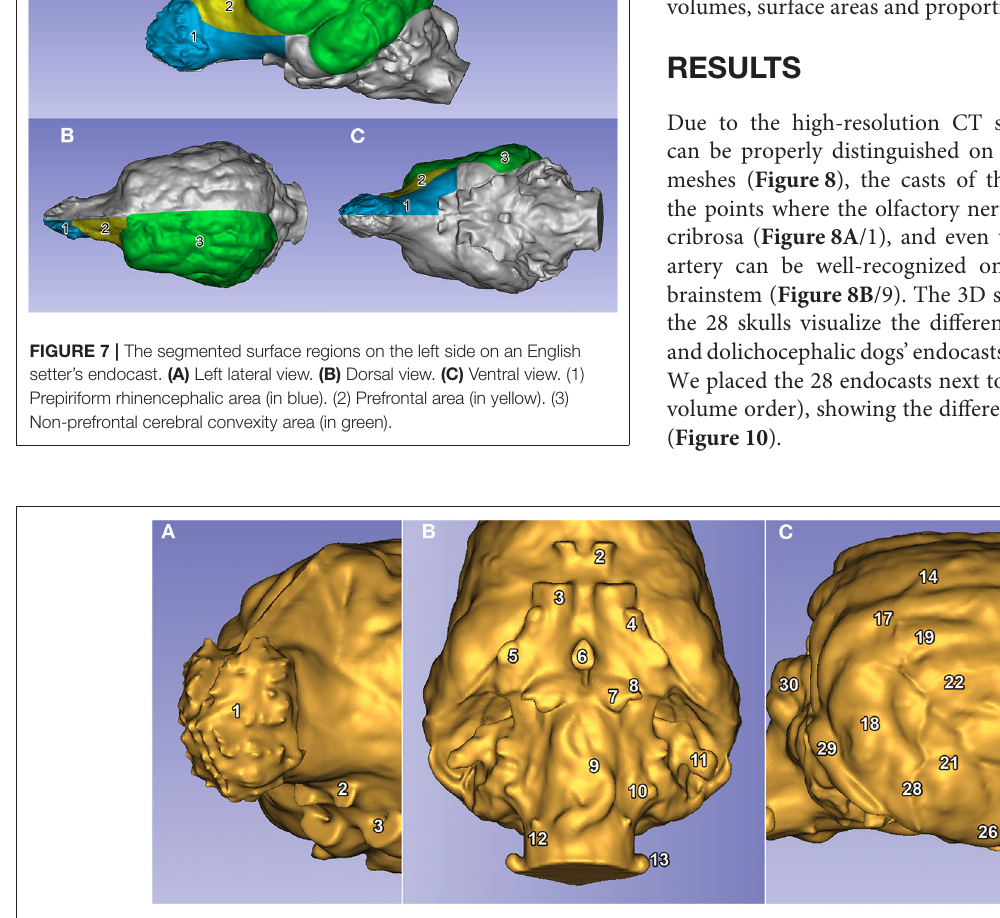
FIGURE 8 | Visible structures on a Weimaraner’s endocast. (A) Left rostro-lateral view. (B) Ventral view. (C) Right caudo-lateral view. The numbers represent the structures of the brain. (1) Bulbus olfactorius. (2) Canalis opticus. (3) Fissura orbitalis. (4) Foramen rotundum. (5) Foramen ovale. (6) Dorsum sellae. (7), Canalis petrooccipitalis. (8) Foramen caroticum. (9) Impression of the A. basilaris cerebri on the medulla oblongata. 10) Foramen jugulare. (11) Fossa subarcuata. (12) Canalis nervi hypoglossi. (13) Canalis condylaris. (14) Gyrus marginalis. (15) Gyrus postcruciatus. (16) Gyrus precruciatus. (17) Gyrus ectomarginalis. (18) Gyrus suprasylvius caudalis. (19) Gyrus suprasylvius medius. (20) Gyrus suprasylvius rostralis. (21) Gyrus ectosylvius caudalis. (22) Gyrus ectosylvius medius. (23) Gyrus ectosylvius rostralis. (24) Gyrus sylvius caudalis. (25) Gyrus sylvius rostralis. (26) Gyrus compositus caudalis. (27) Gyrus compositus rostralis. (28) Impression of the A. meningea media. (29) Sinus transversus. (30) Vermis